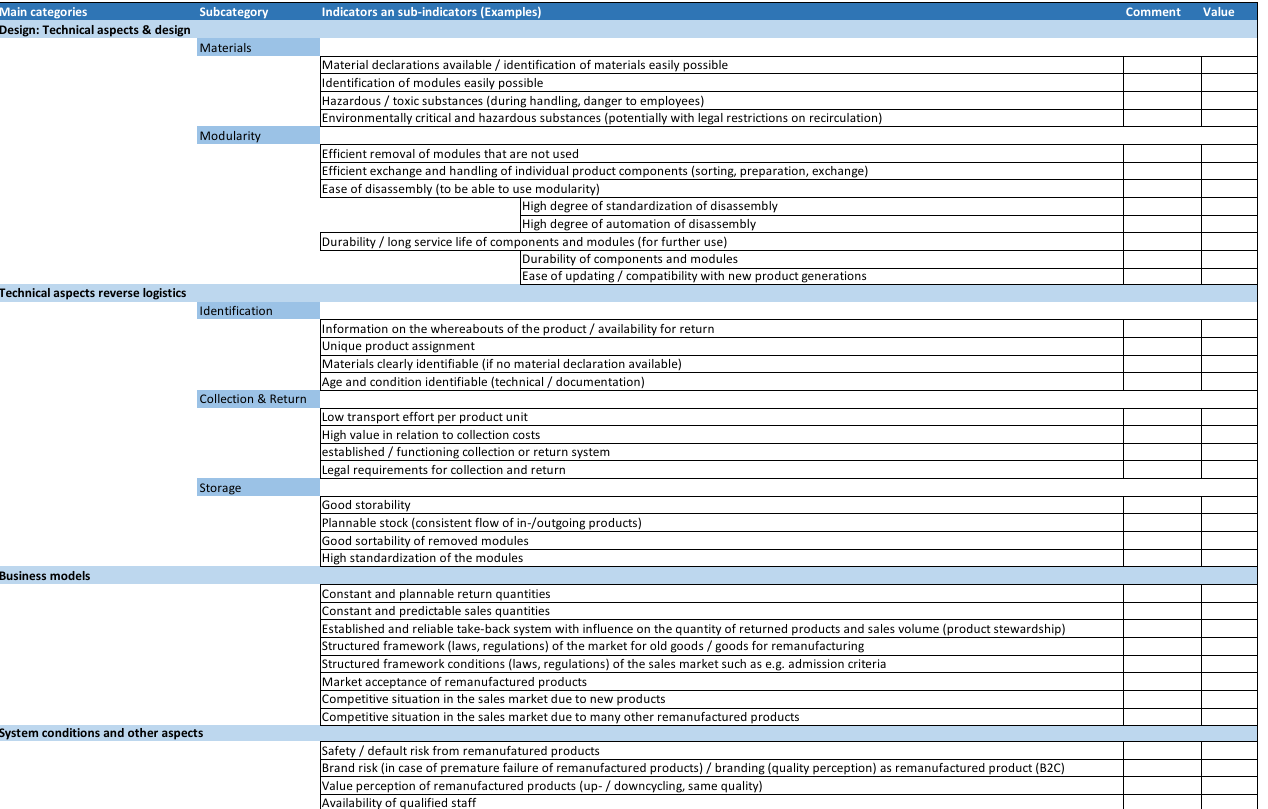
Figure 2. Schematic assessment